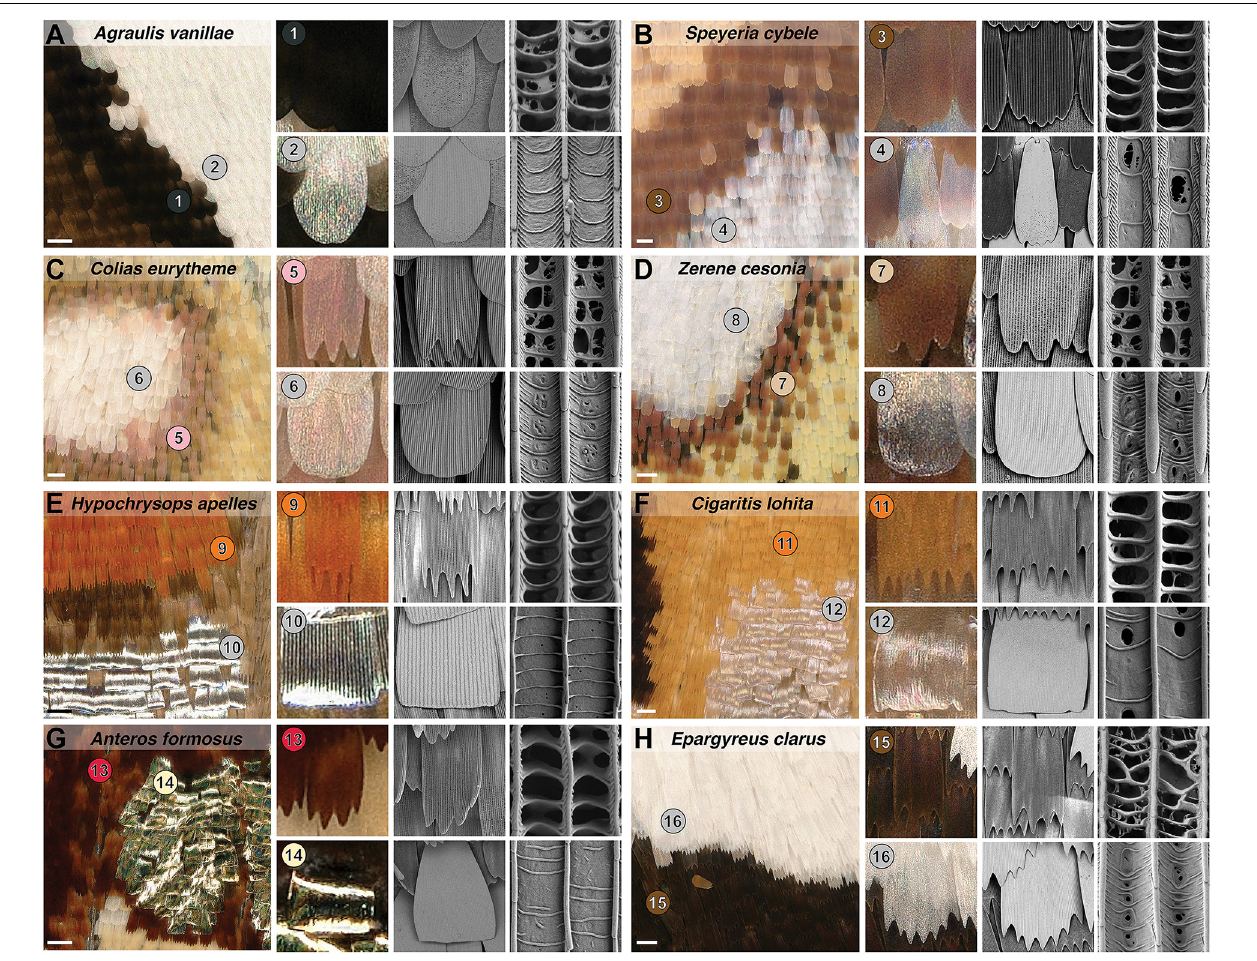
FIGURE 2 | Modified morphologies of metallic scales in five butterfly families. (A,B) Nymphalidae. (C,D) Pieridae. (E,F) Lycaenidae. (G) Riodinidae. (H) Hesperiidae. Each panel shows a silver pattern imaged by digital light microscopy (left insets, scale bars = 100 µ m), and close-up views of non-metallic (upper rows) vs. metallic (lower rows) scales under light and electron microscopy. The right columns show the ultrastructural details of the upper lamina, highlighting the fenestration of non-metallic scales vs. the smooth surface of reflective scales across two inter-ridge intervals. Numbered bullets mark scale types and species that are referred to in further